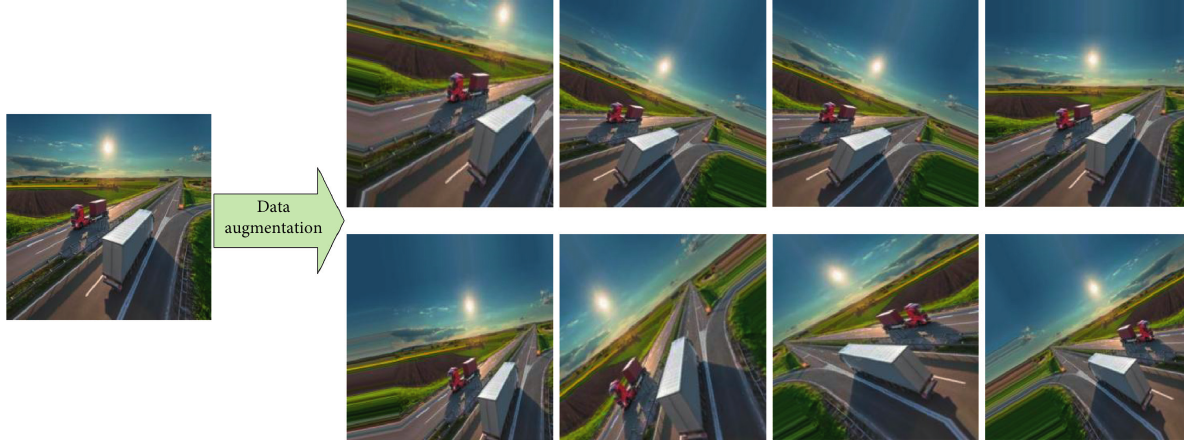
Figure 2: Results of data augmentation.